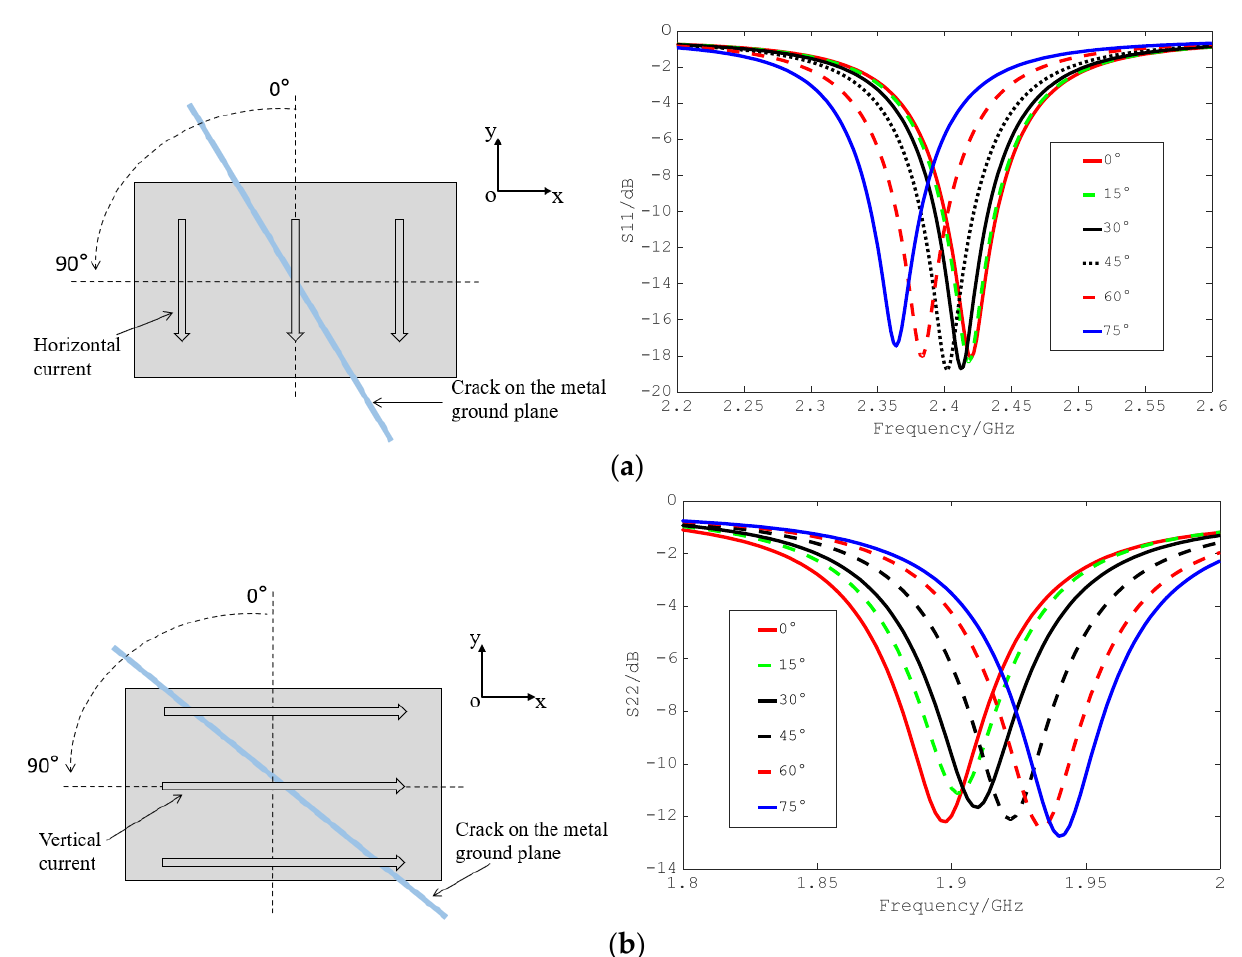
Figure 12. Simulated reflection coefficients of the designed sensor for crack with different directions. ( a ) Port 1. ( b ) Port 2.